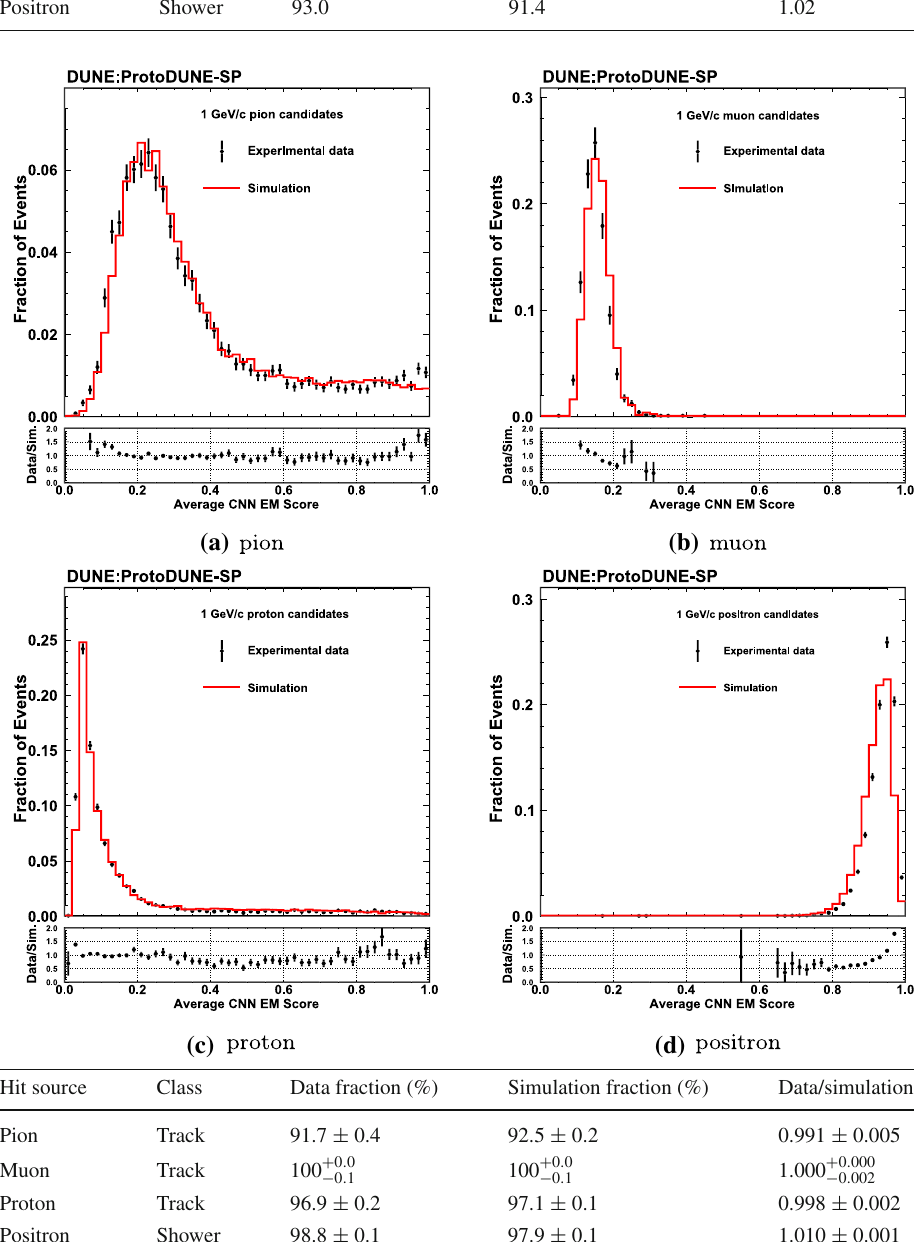
reconstructed particles classified into appropriate class for different samples in ProtoDUNE-SP data and simulation. The errors represent the statistical uncertainties calculated using the Clopper–Pearson method